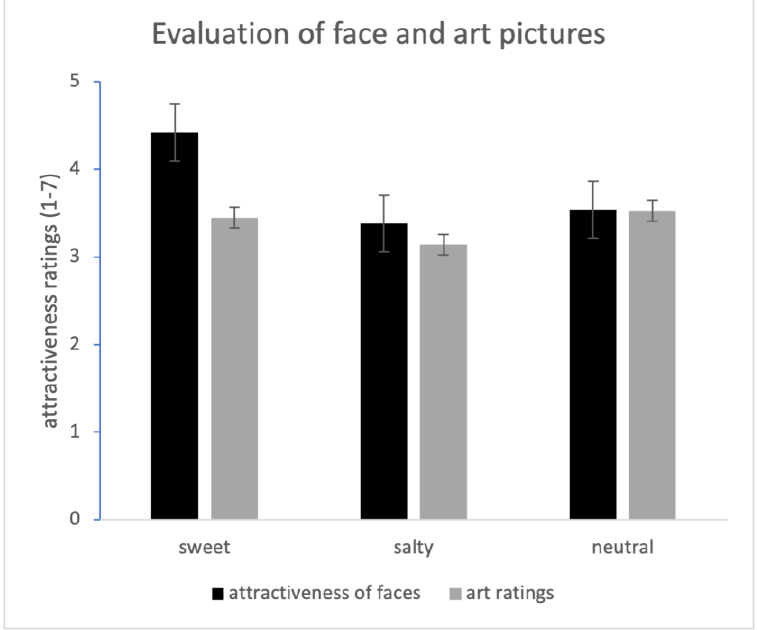
Figure 1. Participants in this study tasted sweet, salty, and neutral stimuli before performing a task in which they had to rate the attractiveness of faces (with art pictures as control stimuli). When briefly experiencing sweet taste before, attractiveness ratings of faces (of the opposite sex) showed higher scores compared with priming with a neutral or a salty taste. Furthermore, the study showed that participants after sweet taste priming reported more often that they could imagine asking the depicted person to invite him or her for a coffee. Thus, sweet taste experiences induced romantic mindsets. In contrast, stimuli unrelated to romantic or approaching behavior, such as abstract art pictures, were not altered by taste experiences (data taken from